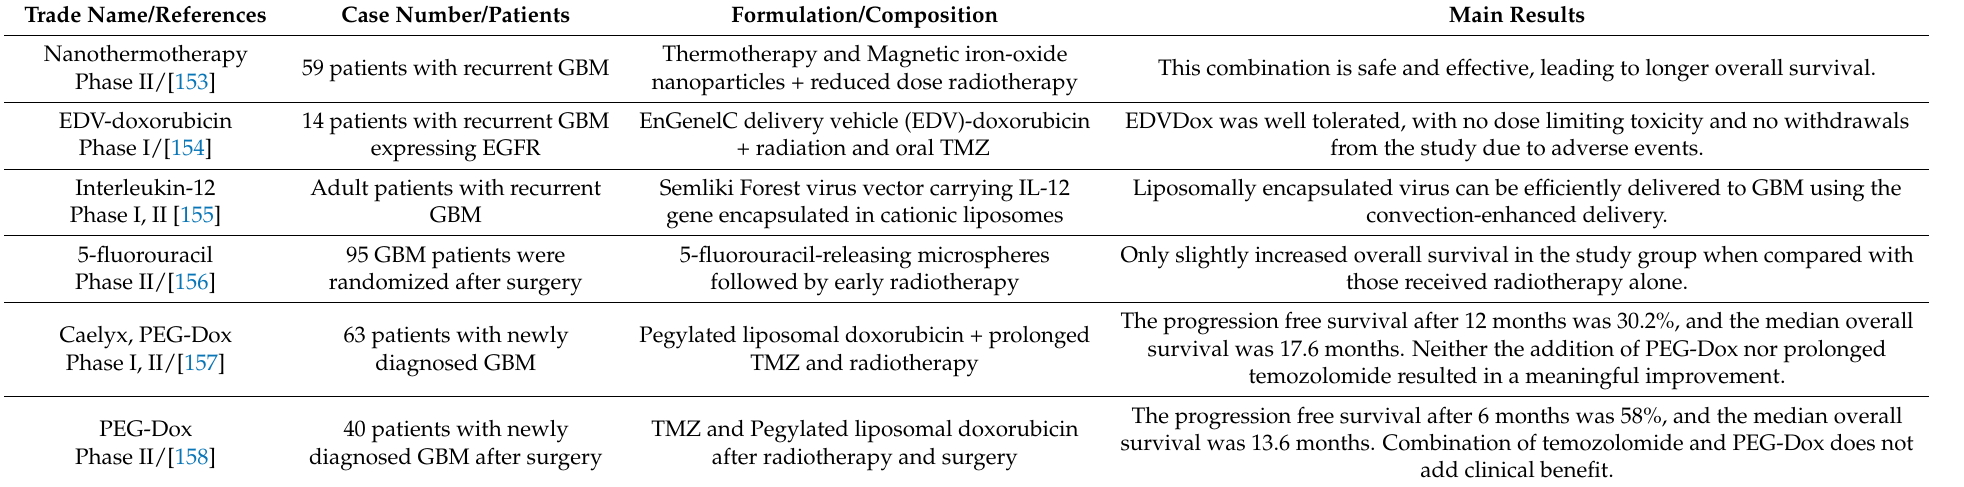
Table 1. Clinical trials using nanotechnology and nanocarrier-based delivery systems for treating glioblastoma